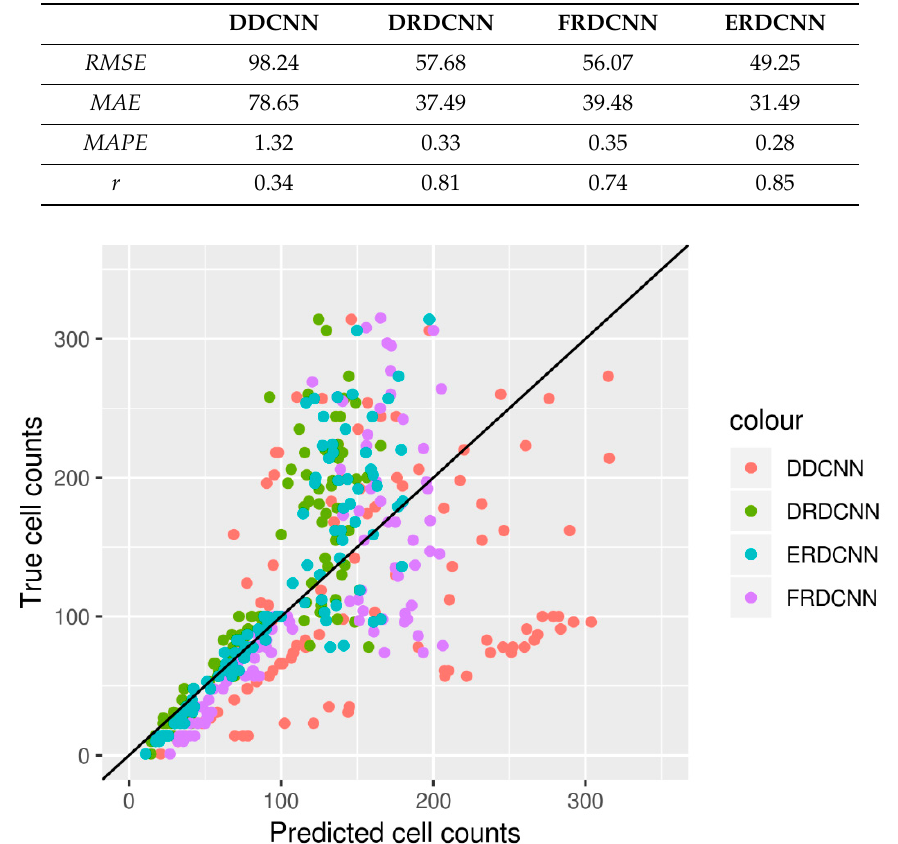
Figure 3. Cell counts predicted by the four models vs. their true cell counts based on the 100 test images. Predictions made by the ERDCNN model were closer to the true cell counts; especially for those images with smaller cell counts (e.g., the number of cells is smaller than 100).